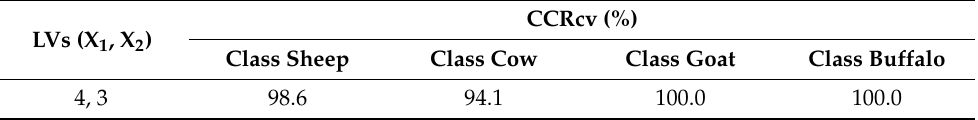
Table 2. SPORT analysis for classification of FA profiles according to the type of milk.